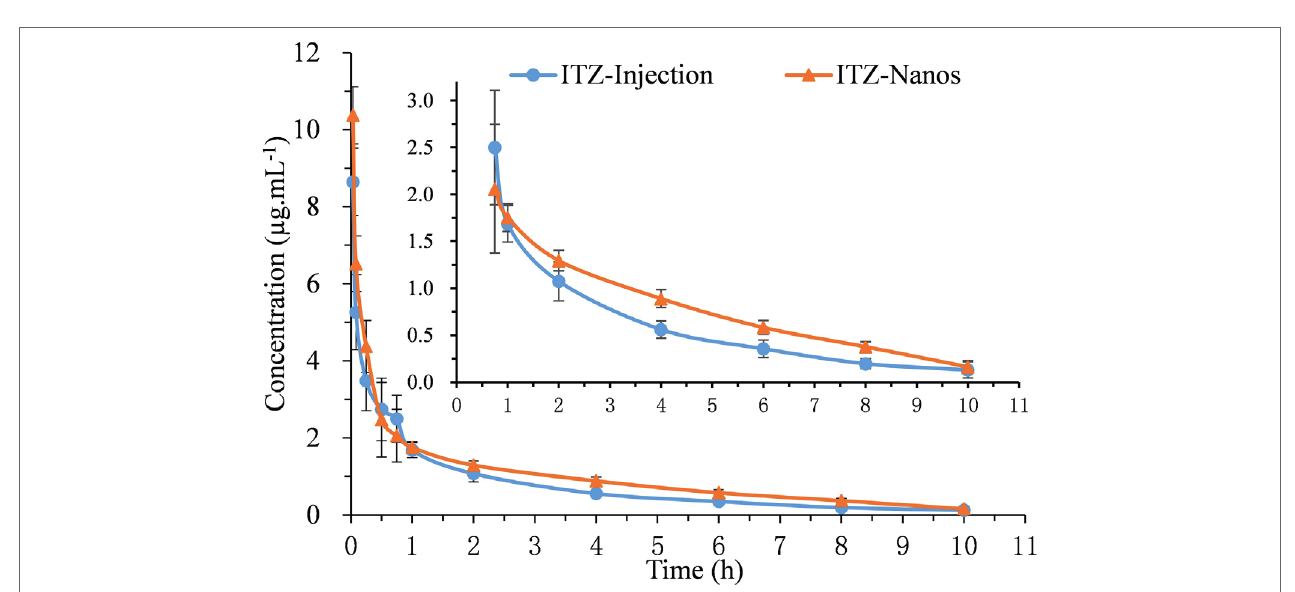
FIGURE 3 | In vitro dissolution of ITZ injection and ITZ-Nanos.